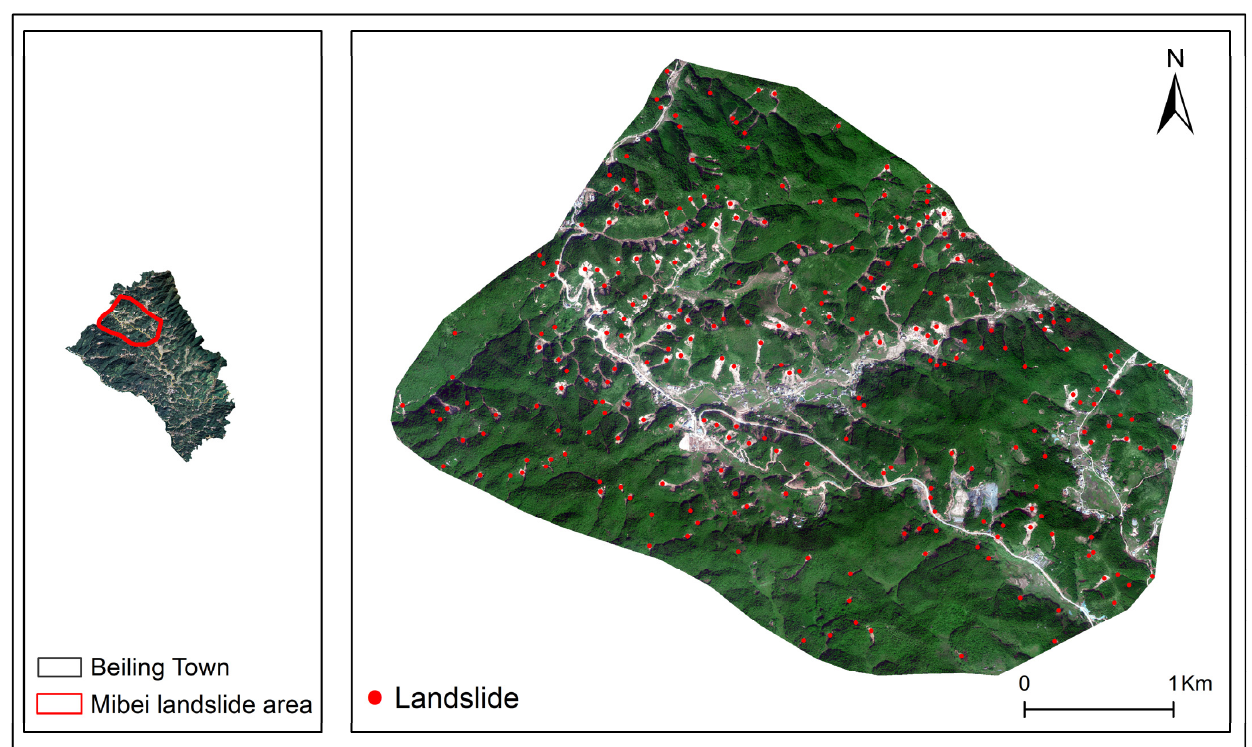
Figure 2. The landslide area is located in Mibei Village, Beiling Town, Longchuan County, Heyuan City, Guangdong Province, China. The red points are the locations of landslides identified after the survey.